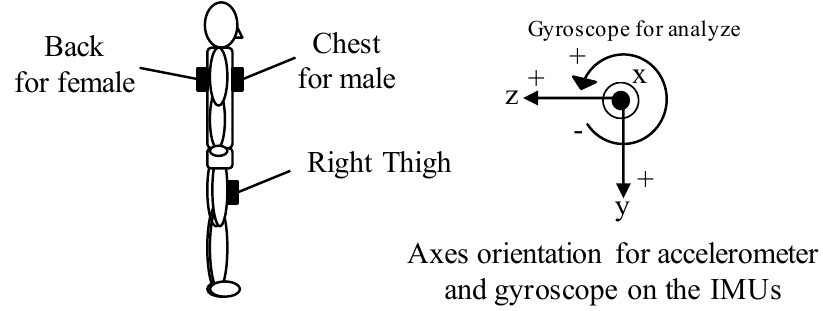
Figure 1. Inertial sensor attachment and its axis